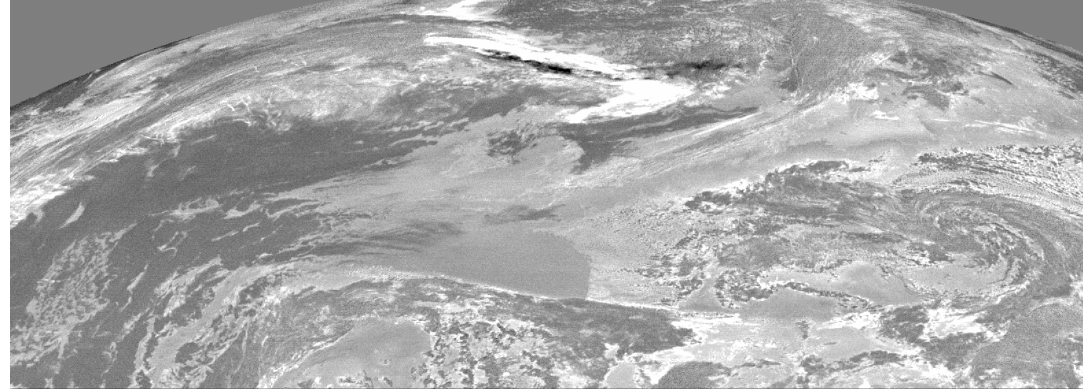
Figure 15. Brightness temperature image at 12 µ m. The scale ranges from 230 K (white) to 300 K (black).